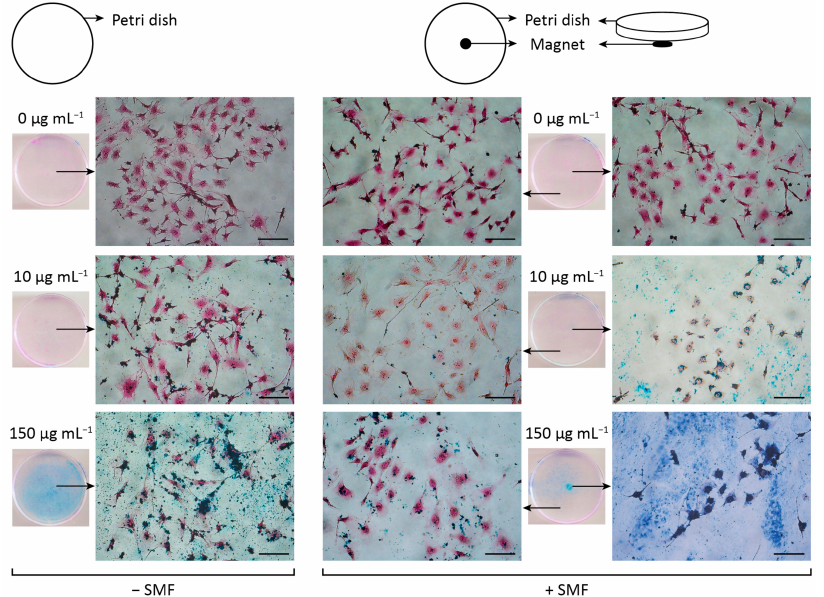
Figure 8. MAG.PEG steering by the application of an external static magnetic field (SMF) . The vGPCR cells were incubated with 10 or 150 µ g mL − 1 of MAG.PEG or distilled water as control in the presence (right panel) or absence (left panel) of a SMF for 48 h. Representative micrographs of the cells after the Prussian blue and H&E stain were taken under an inverted light field microscope. Arrows displayed from the culture dishes indicate the area of the micrograph acquisition. Scale bar= 100 µ m. Magnification 200 ×